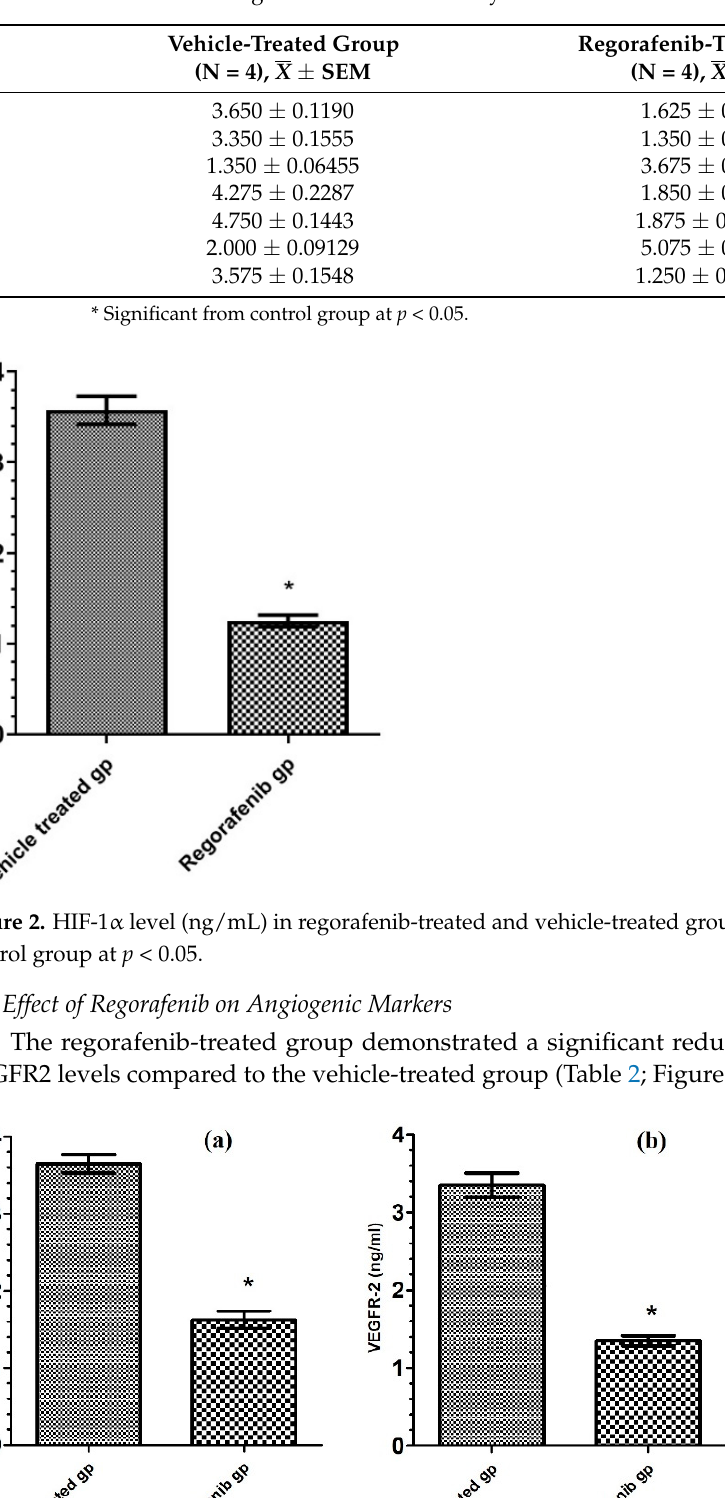
5 Figure 1 . The viability of MCF-7 cells treated by regorafenib (1.25–40 μ M). 3.2. Effect of Regorafenib on HIF-1 α as Hypoxia Marker